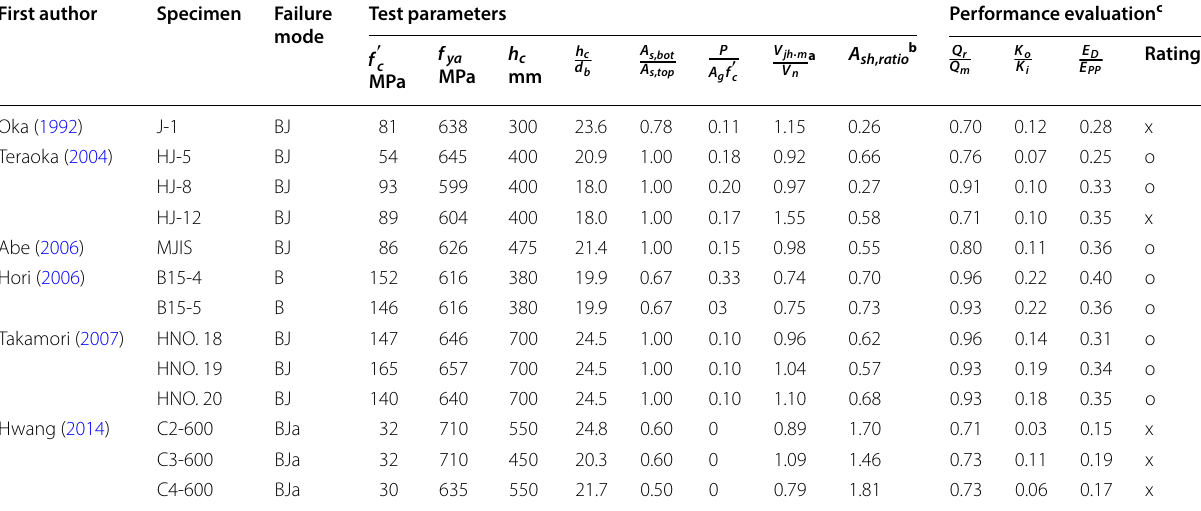
Failure mode: “B”, beam flexural failure; “BJ”, Beam yielding followed by Joint shear failure; “BJa” Beam yielding followed by Joint anchorage failure. a Experimental-to-nominal joint strength ratio per ACI 318.